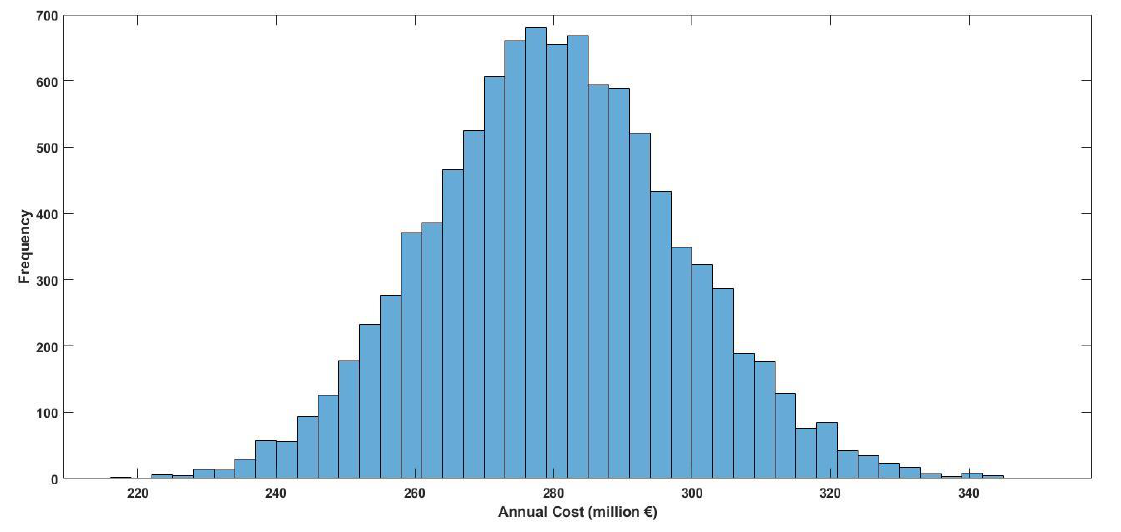
Figure 16. Simulation of yearly costs in 2019 with calculated